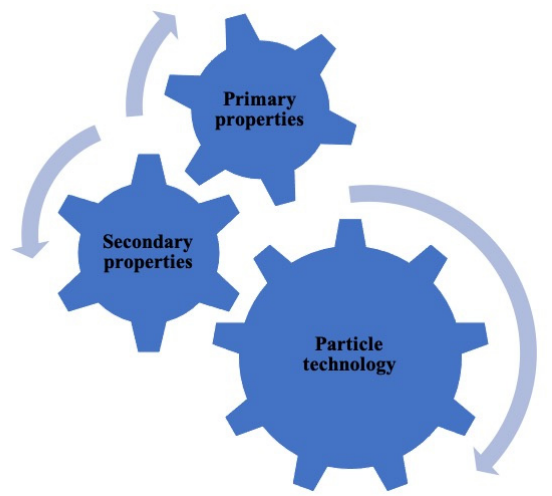
Figure 2. Properties of particulate materials.